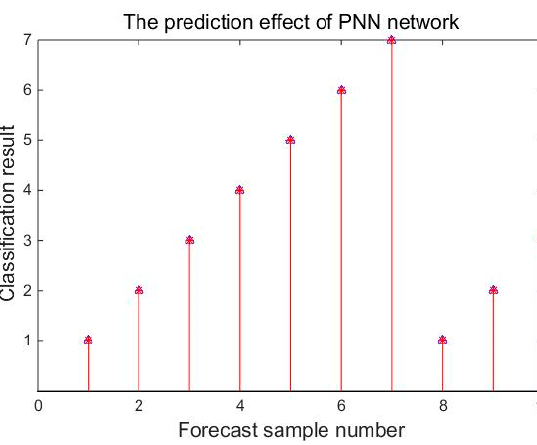
Figure 12. Prediction effect of the PNN.